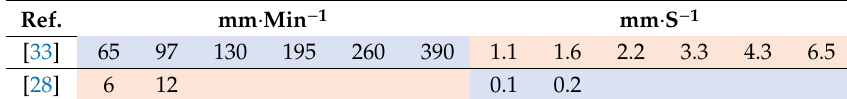
Table 5. Values provided in the publication consulted for axial movement in millimetre per minute and millimetre per